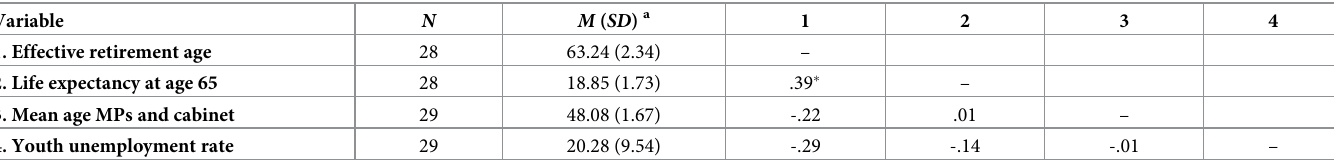
Table 9. Descriptive statistics and correlations for the country-level predictors (Study